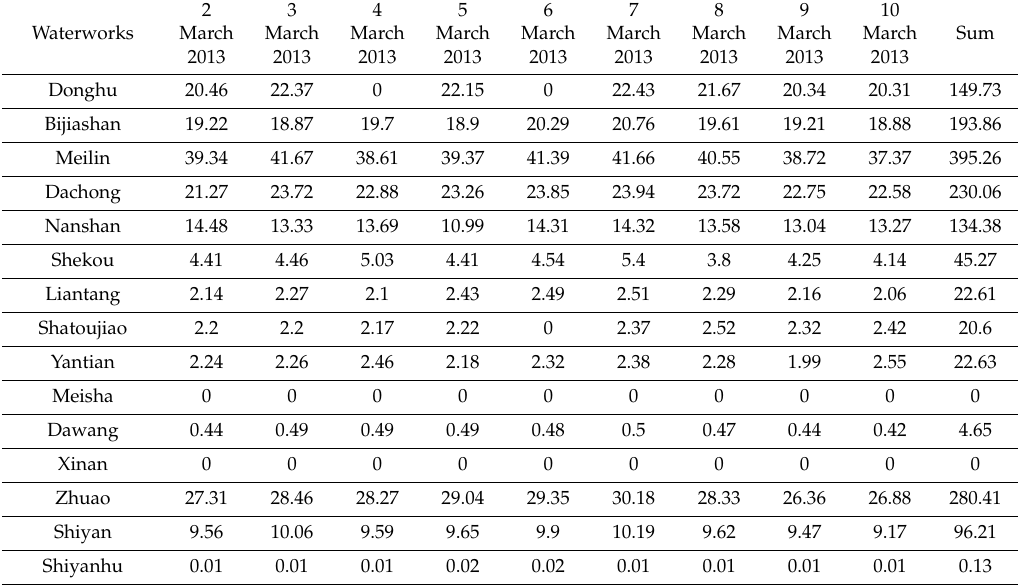
Table A3. Water demand of waterworks from 2 March 2013 to 10 March 2013.